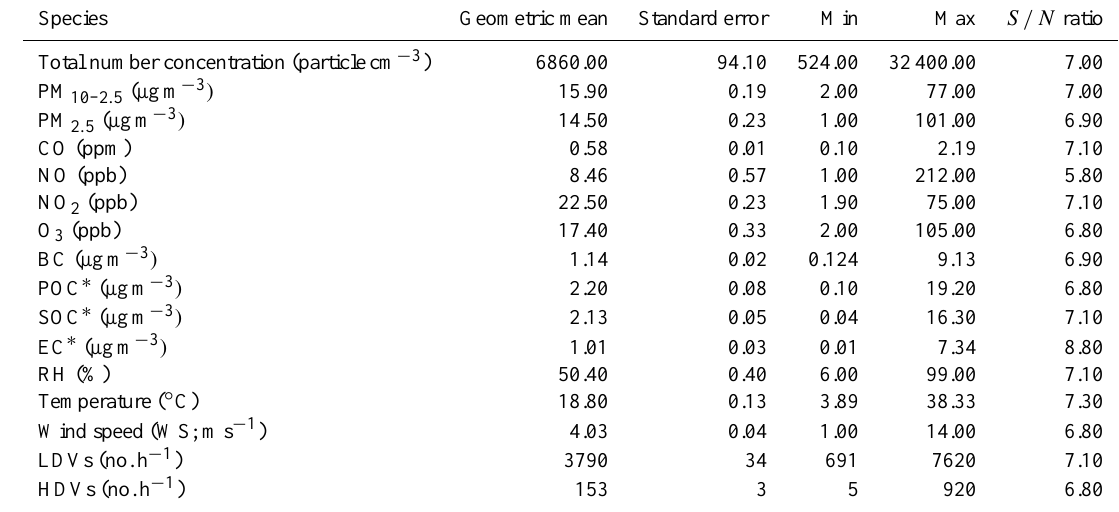
Table 2. Summary statistics for the parameters included in the PMF model. Species Geometric